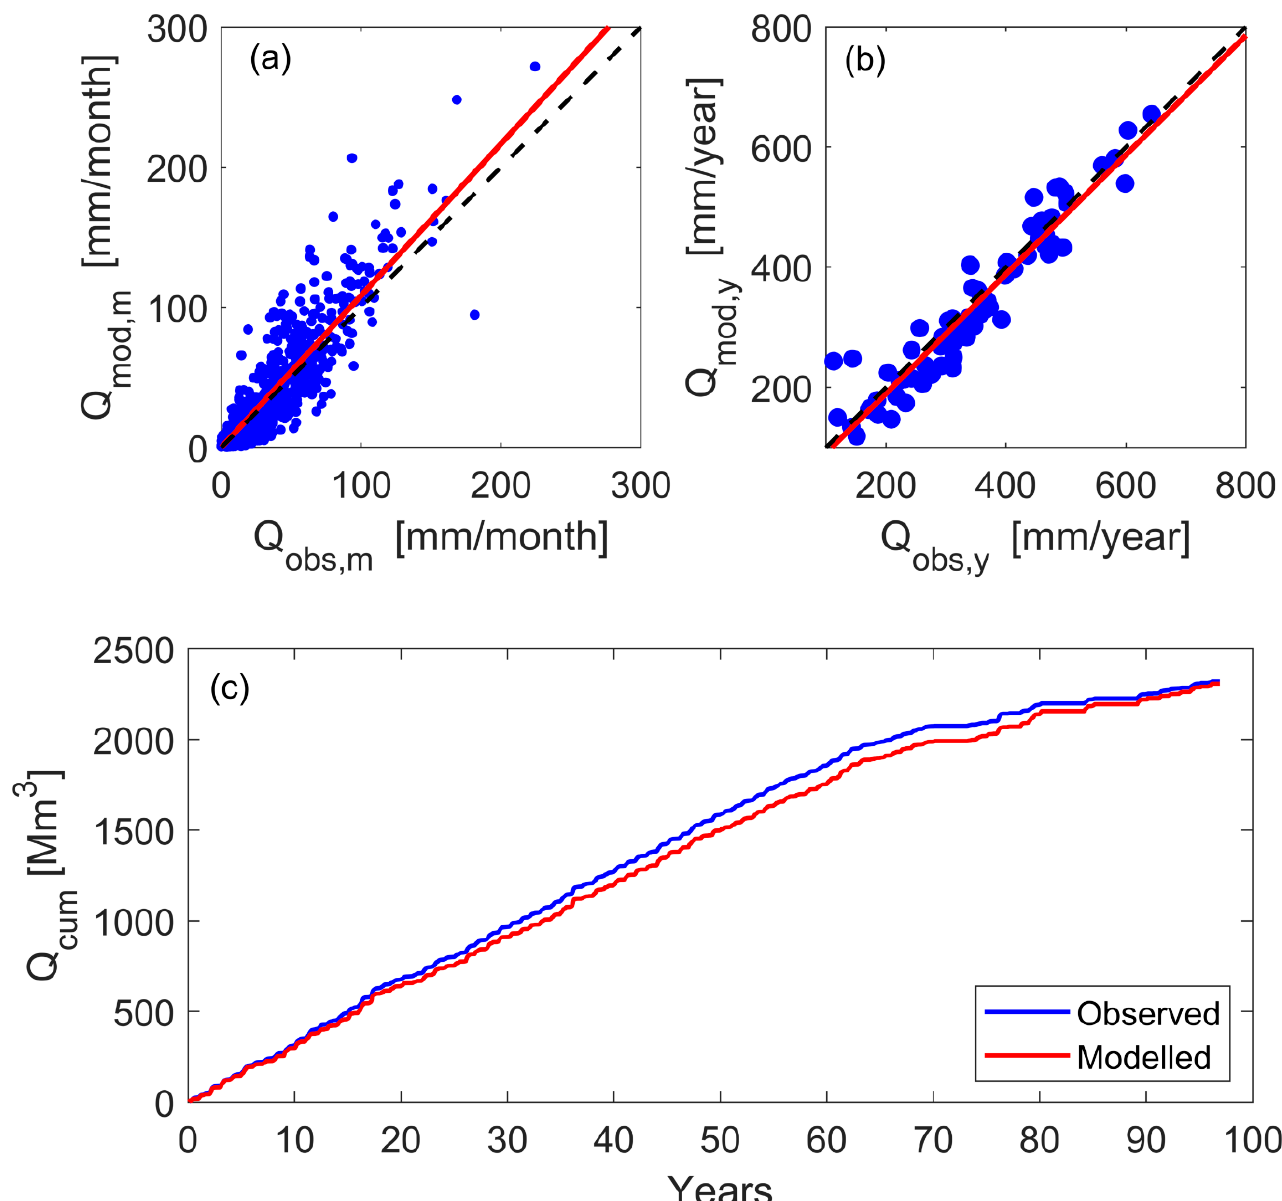
Figure 7. For the historical period, the comparison between observed and modeled runoff of the Rio Fluminimaggiore basin at ( a ) monthly timescale (regression line in red with slope of 1.08; R 2 = 0.83; p- value = < 10 5 ) and ( b ) yearly time scale (regression line in red with slope of 0.99; R 2 = 0.90; p value = < 10 5 ) ( c ) cumulative runoff (Q cum , missing observed values are also not considered in the model time series; values are expressed in millions of cubic meters (Mm 3 )). Table 4. Past mean changes (1976 − 2000 with 1951 − 1975) of annual precipitation (P y ), air temperature (T y ), and predicted annual runoff (Q y ), evapotranspiration (ET y ), and tree LAI (LAI t,y ) using obser- vations of the Sardinian meteorological network and the HadGEM2-AO meteorological data as model input.